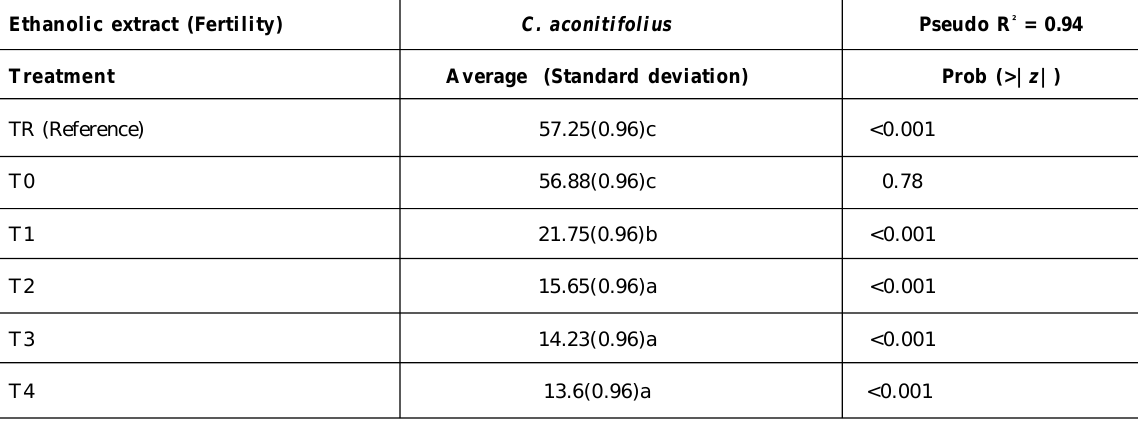
Table 6 : Result of linear regression applied to fecundity of C. maculatus under the effect of ethanolic extract of C. aconitifolius